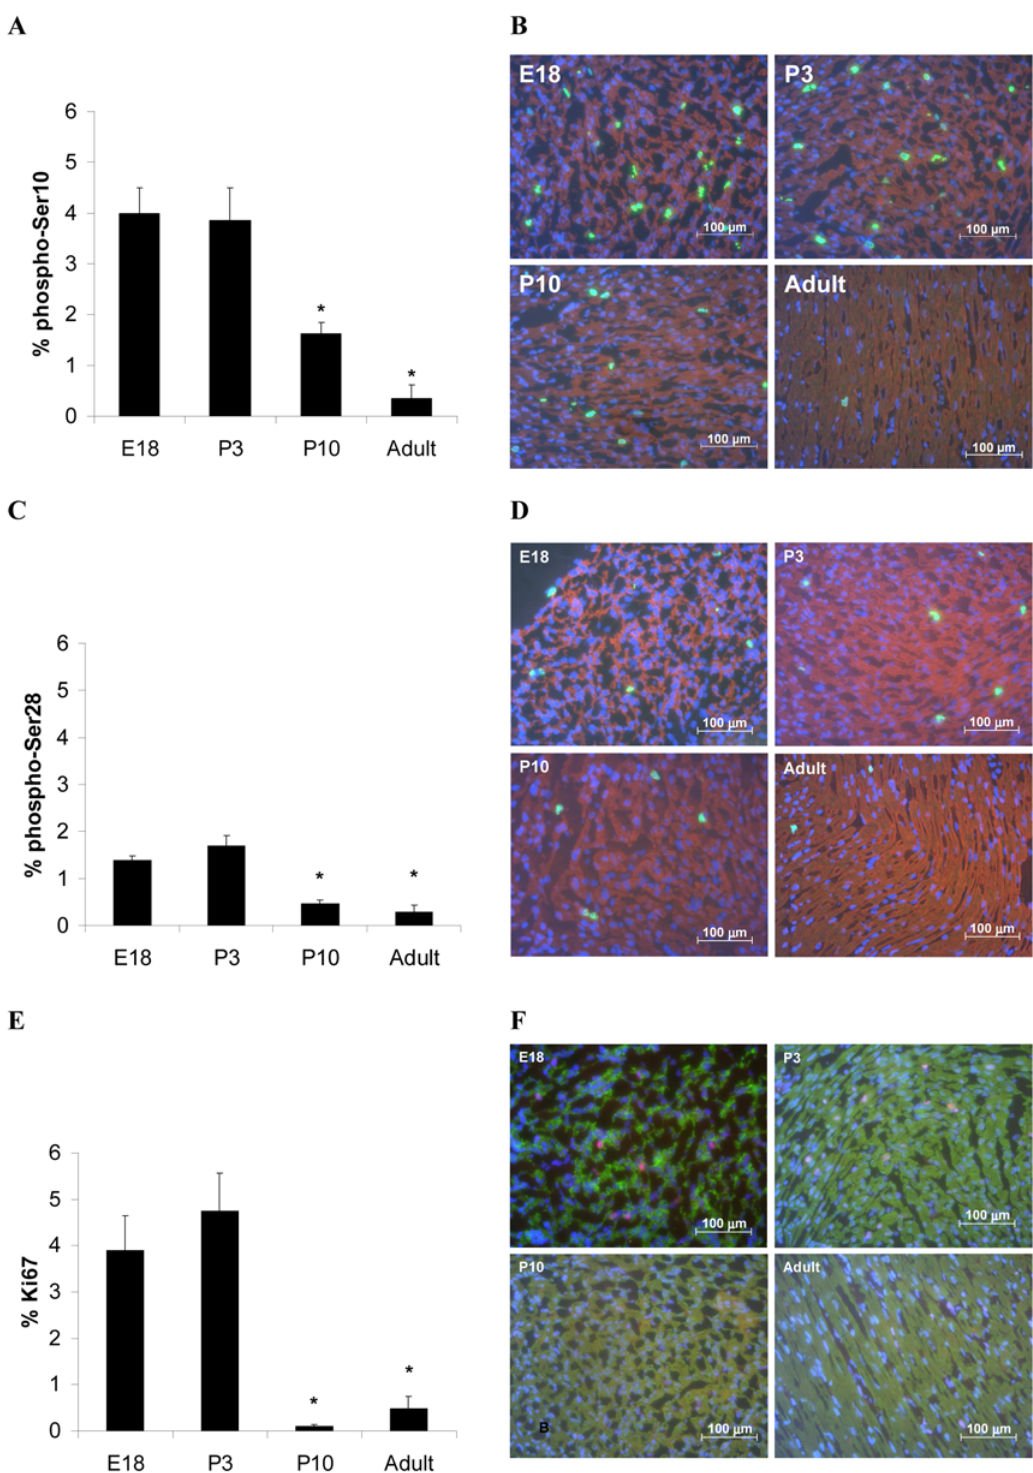
Figure 7. Loss of cell cycle markers from the developing rat heart correlates with the decline in proliferative capacity of the cardiac myocyte. Hearts were excised from embryonic (E18), neonatal (P3 and P10), and adult Wistar rats, frozen in embedding media and sections were cut at 4 m m. Left hand panel (A, C and E) show bar chart summaries (n=3, SEM, * p , 0.05) while the right hand panel (B, D and F) show representative sections for each cell cycle marker at each age group. (B) Cardiac myocytes were identified by the cardiac myocyte-specific marker, tropomyosin (red), histone H3 phosphorylated at Ser10 (green), and nuclei were stained with DAPI (blue). (D) Cardiac myocytes were identified by the cardiac myocyte- specific marker, tropomyosin (red), histone H3 phosphorylated at Ser28 (green), and nuclei were stained with DAPI (blue). (F) Cardiac myocytes were stained with the cardiac myocyte specific marker, troponin I, Ki67 staining is red and DNA was stained with DAPI (blue).